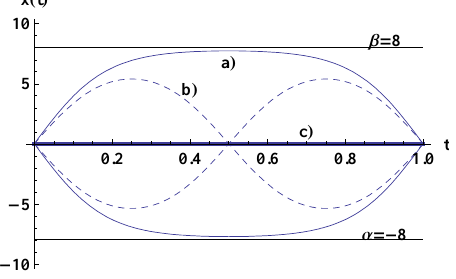
Figure 1. All solutions of the problem (3.11)–(3.12): a) the 0 -type solutions; b) the 1 -type solutions; c) the 2 -type solution (the unique one).